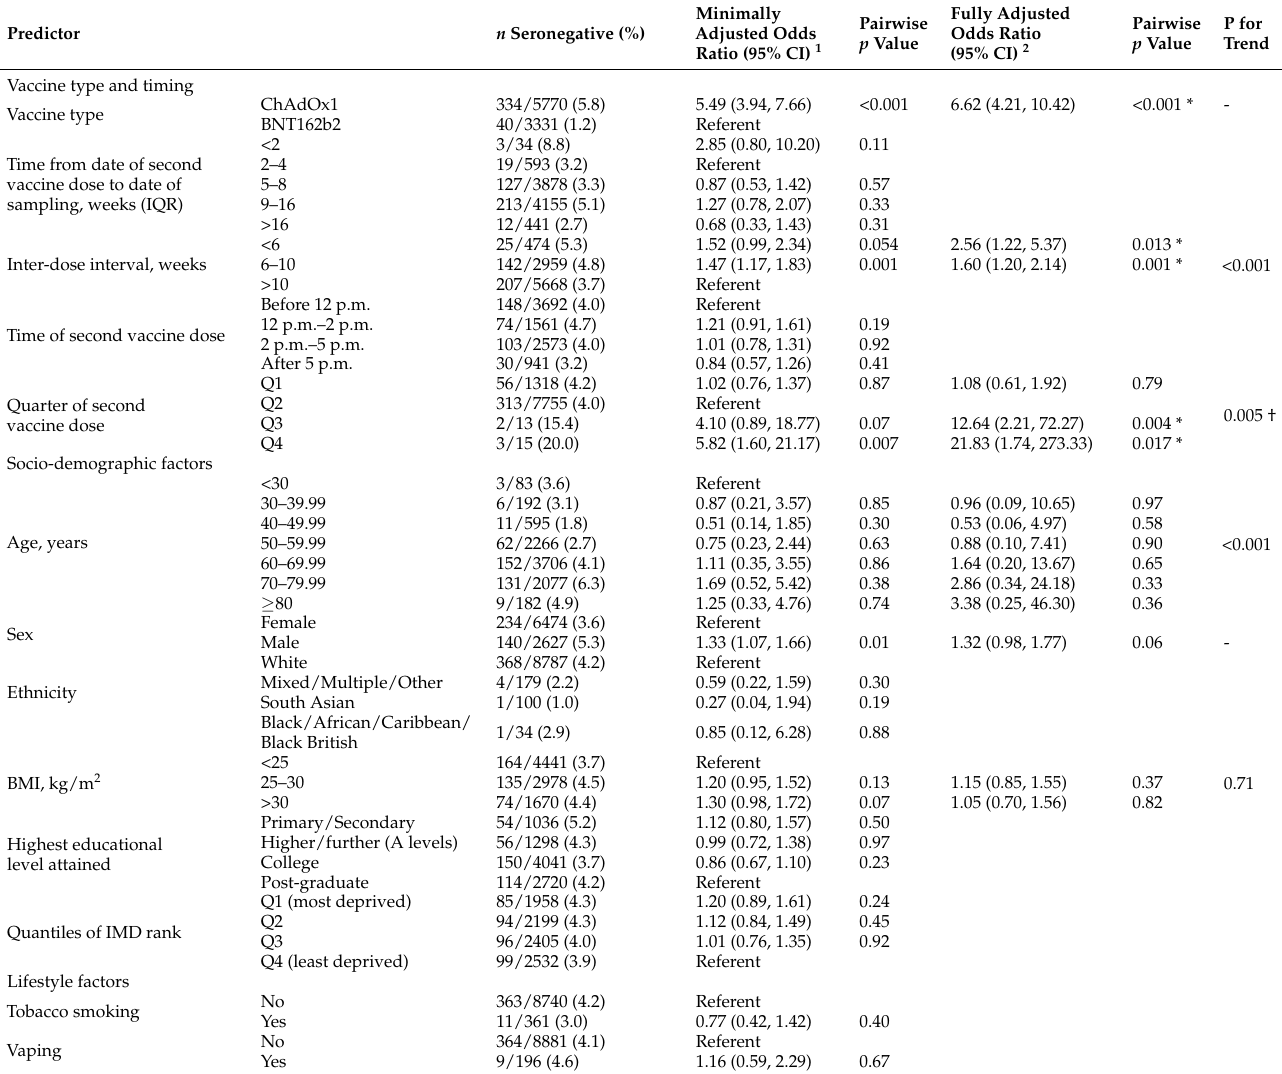
Table 2. Determinants of post-vaccination seronegativity, all participants ( n =